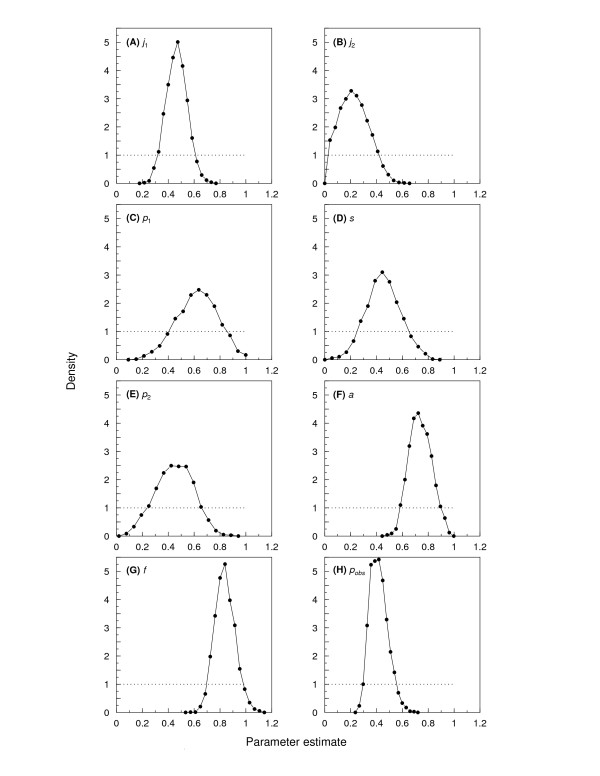
Probability densities of the last 1,000 iterations of the WinBUGS estimation for the estimated demographic parameters. (see Fig. 3 and Equation 2): j1 (A), j2 (B), p1 (C), s (D), p2 (E), a (F) and f (G). The medians, 2.5 and 97.5 percentiles are: j1: 0.45, 0.29, 0.61; j2: 0.20, 0.02, 0.44; p1: 0.60, 0.27, 0.89; s: 0.42, 0.17, 0.69; p2: 0.42, 0.14, 0.69; a: 0.72, 0.57, 0.90; f: 0.82, 0.68, 0.98, and pobs: 0.40, 0.29, 0.55. The priors are indicated by dotted lines.